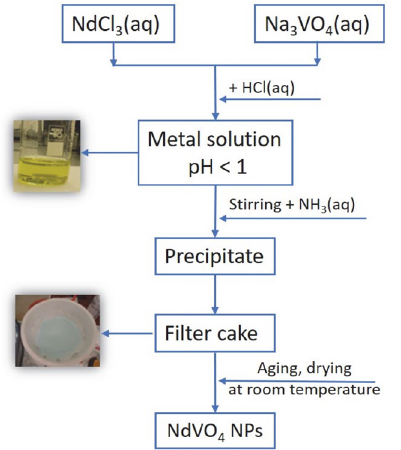
Fig. 1. A schematic representation of the synthetic procedure to ob- tain NdVO 4